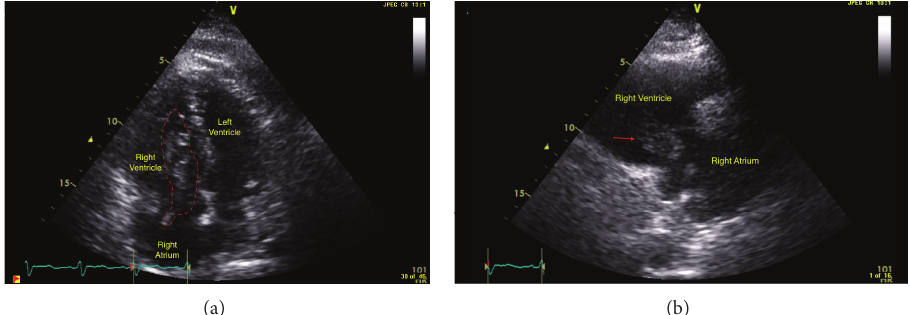
Figure 2: (a) An apical 4-chamber echocardiographic view of the heart showing the right heart thrombus protruding through the tricuspid valve. (b) A right ventricular inflow echocardiographic view of the heart showing the right heart thrombus protruding through the tricuspid